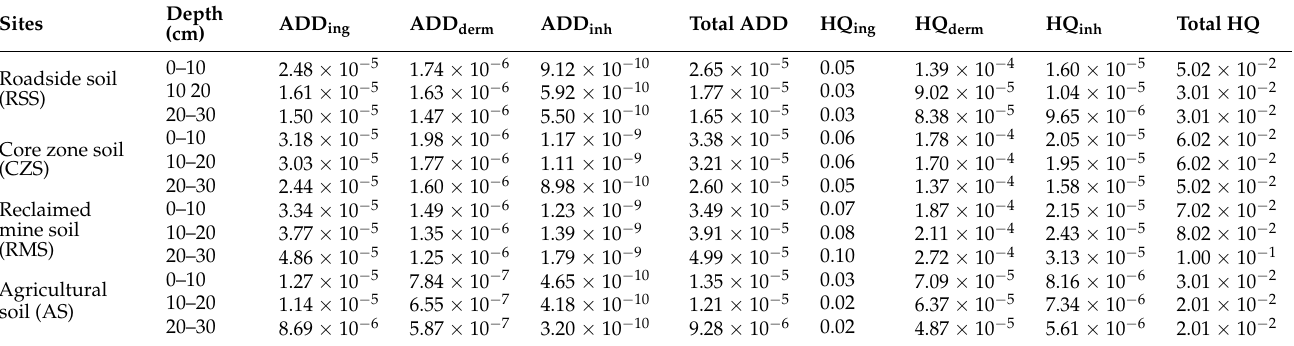
Table 4. Average daily dose (ADD) and hazard quotient (HQ) of Cd in three soil profiles (0–10,